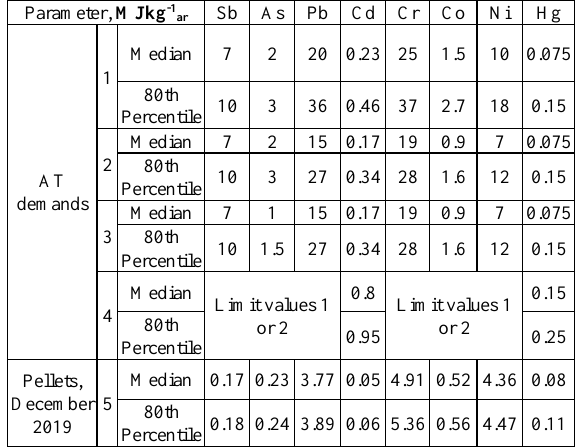
Hg limit values for sewage sludge and paper fibre residues; 5: statistical evaluation of 10 daily representative samples for the month